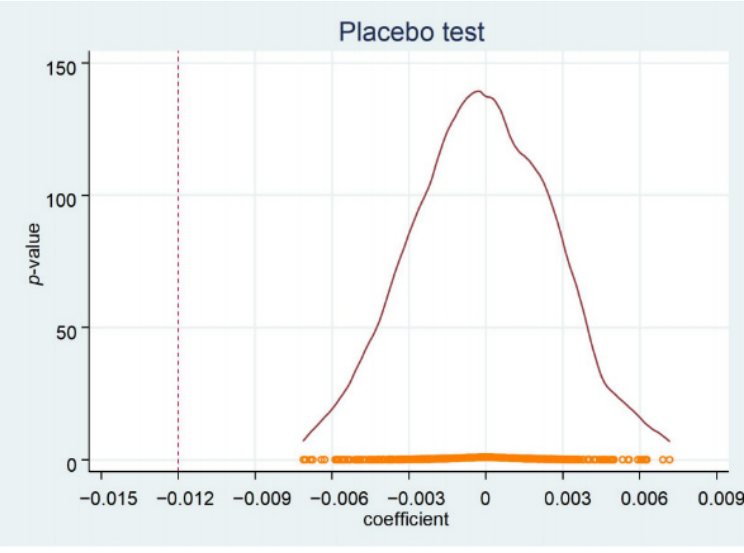
Figure 4. Placebo test (800